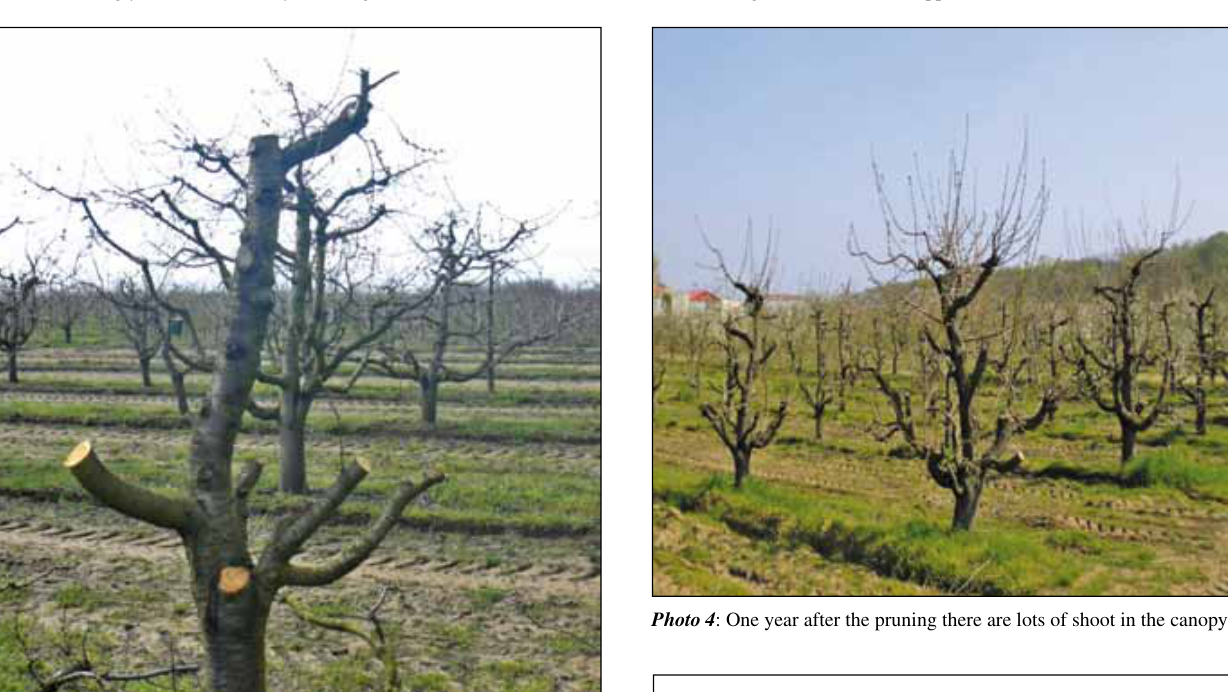
Photo 1 : Strongly balded sour cherry tree at age of 21 Photo 3 : Huge amount of shoots appear after the treatment